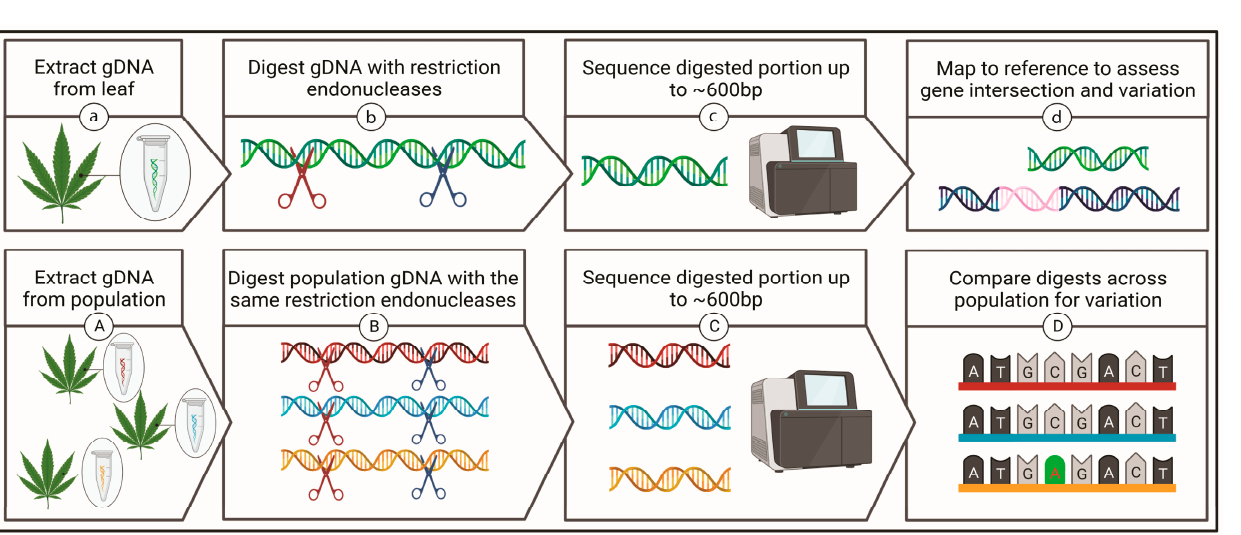
Figure 1. Simplified overview of two complexity reduction approaches. ( a ) Genomic DNA is extracted and ( b ) digested with restriction endonucleases prior to ( c ) sequencing and ( d ) mapping to a publicly available reference assembly. The use of a reference sequence allowed assessment of fragments able to be mapped to known coding sequences or genetic features. A slightly varied application requires the ( A ) extraction of genomic DNA from a population which is then ( B ) digested prior to ( C ) sequencing, after which sequences are ( D ) compared to one another to assess geneticvariation of isolated fragments across the population without the use of a reference assembly. Created with BioRender.com accessed on 17 August